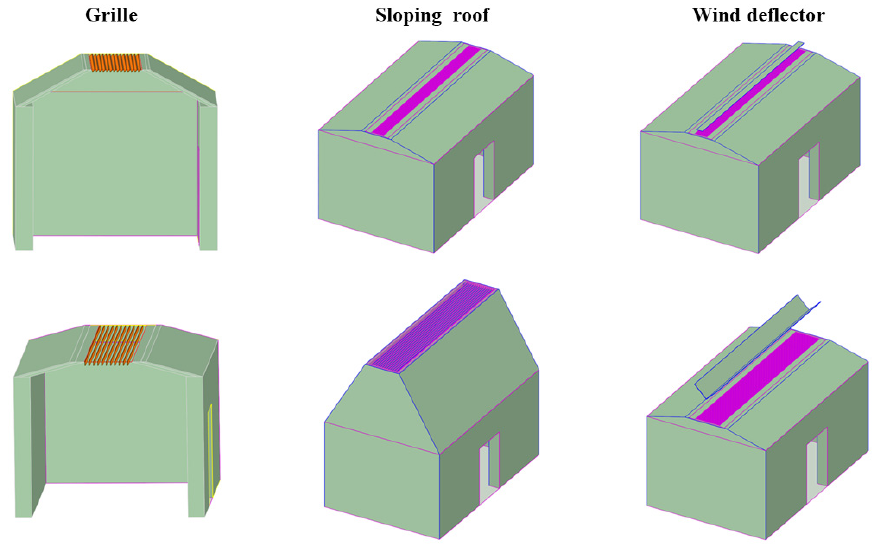
Figure 5. Changes in various structures.